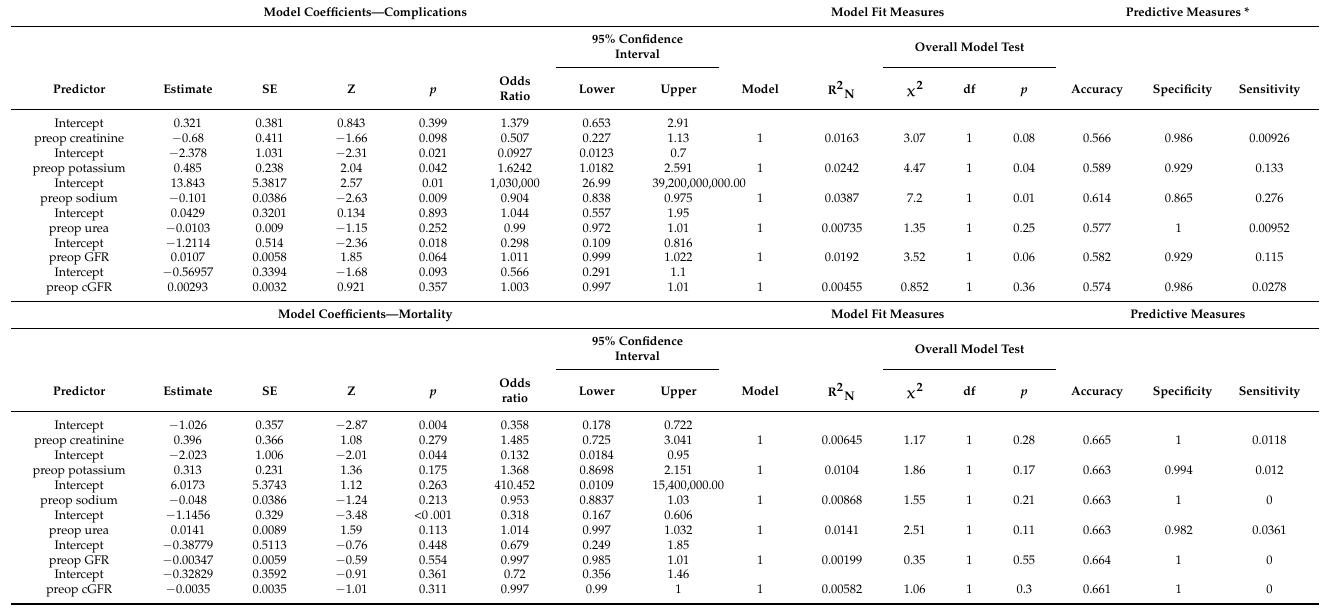
Table 2. Overview Model Coefficients: Models for predictability of the preoperative parameters (creatinine, potassium, sodium, urea, GFR, and cGRF) of complications, mortality, and failure of the graft. * Note. The cut-off value is set to